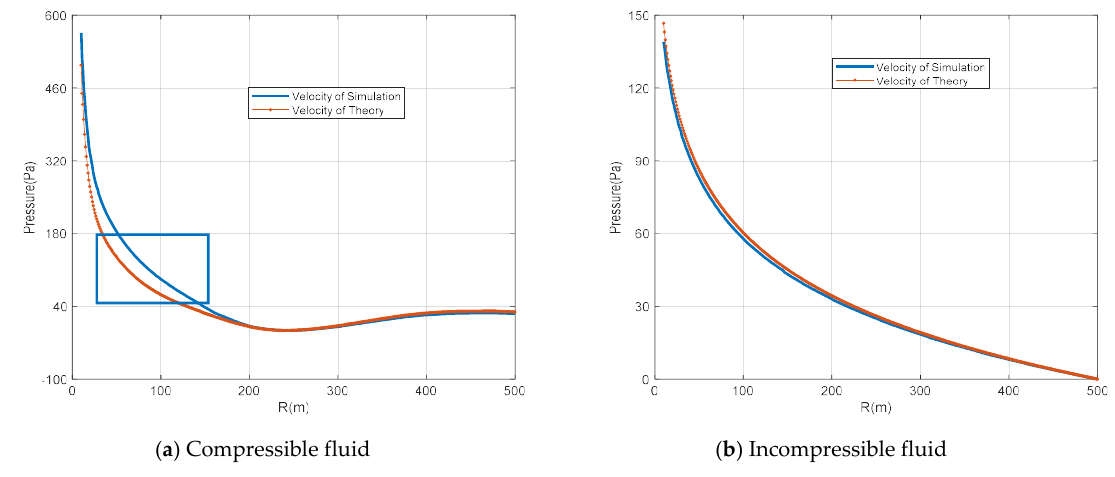
Figure 9. The pressure of case 2 on the line X = 0, Y = (10,500).